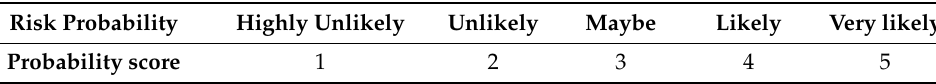
Table 1. Assessment of the risk probability.